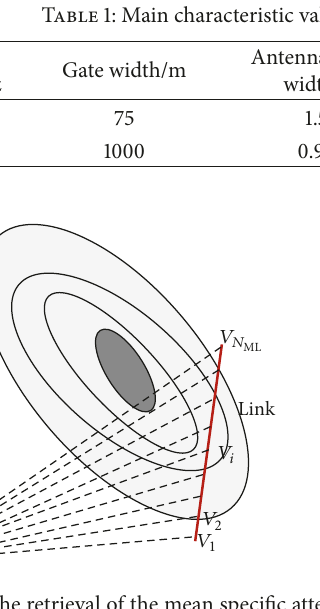
Figure 2: Sketch map of the retrieval of the mean specific attenua- tion along link path by